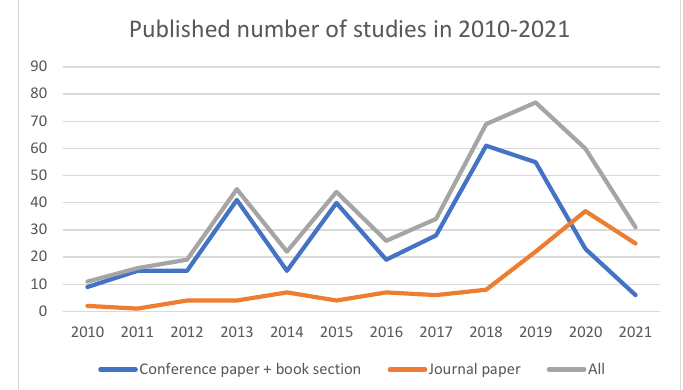
Figure 5. Number of studies published through years 2010–2021 (all = 454).